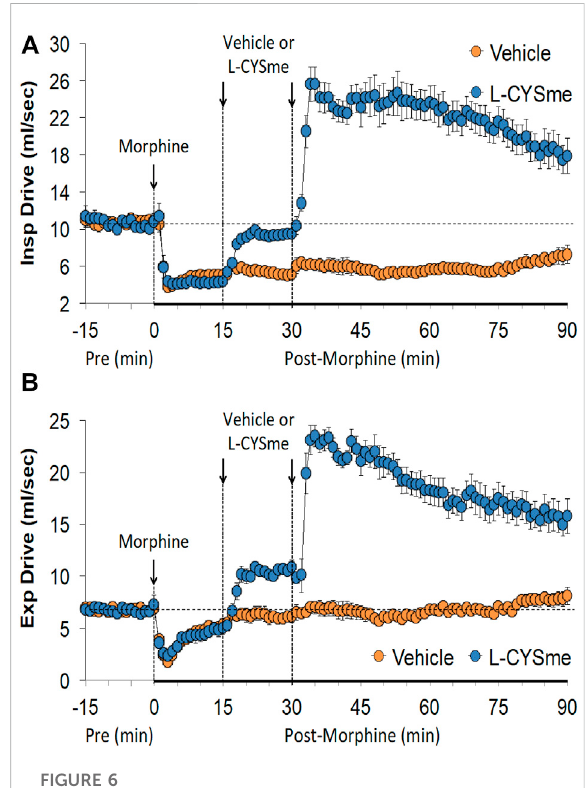
FIGURE 6 Inspiratorydrive(Panel (A) andexpiratorydrive(Panel (B) prior to (Pre), following the injection of morphine (10 mg/kg, IV), and then two injections of vehicle or L-cysteine methyl ester (L-CYSme, 500 μ mol/kg, IV) given 15 min apart, in freely- moving rats. The data are presented as mean ± SEM. There were 6 rats in each